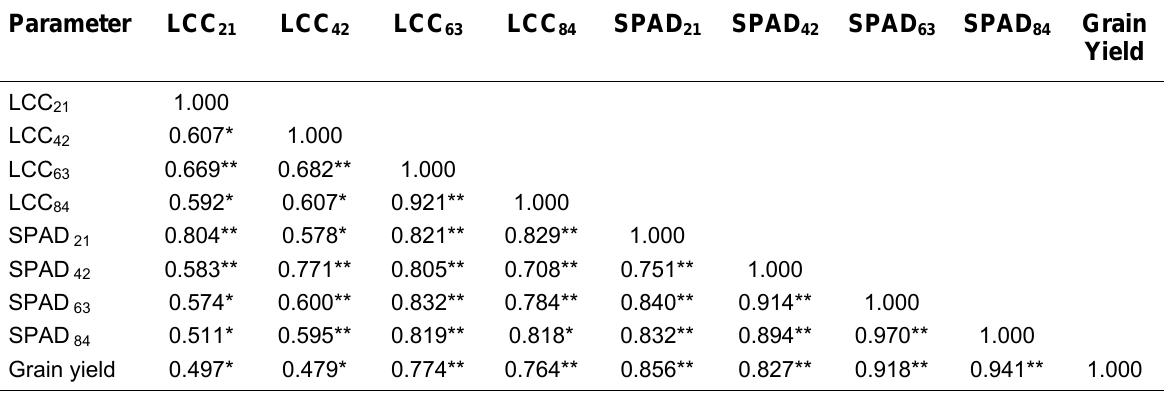
Simple Correlation Matrix Showing the Relationship of LCC and SPAD Values at Different Growth Period of Rice with Grain